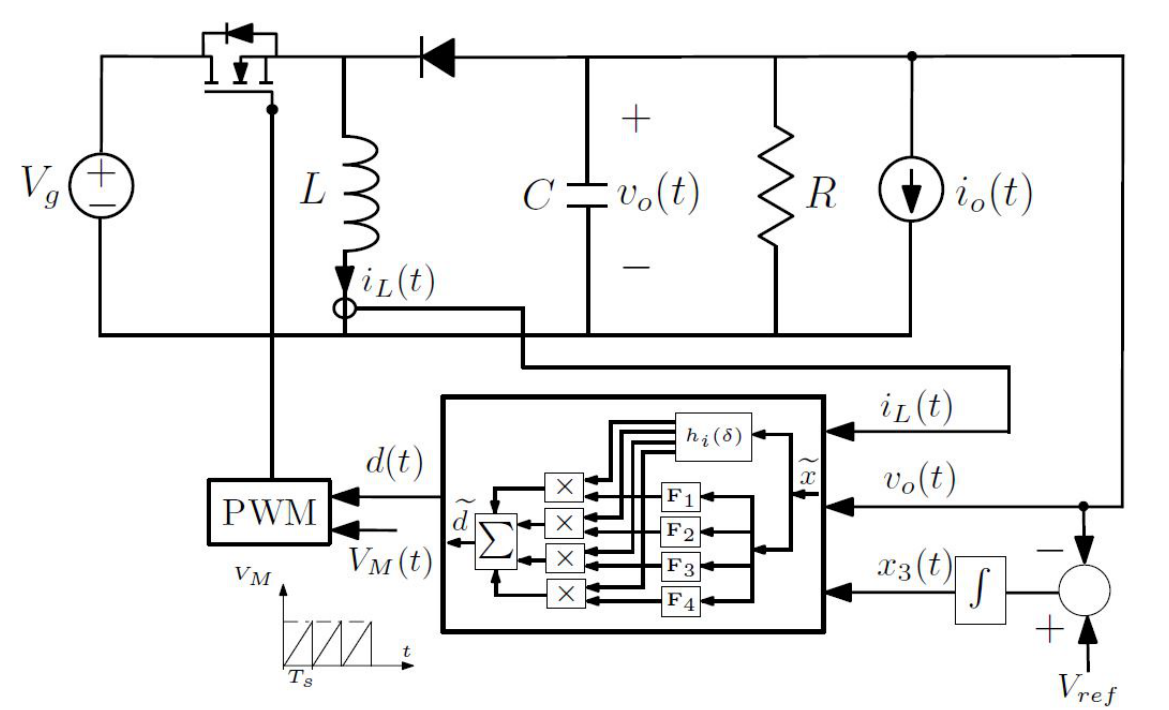
Figure 5. Circuital diagram of a buck-boost converter with the LMI-Fuzzy